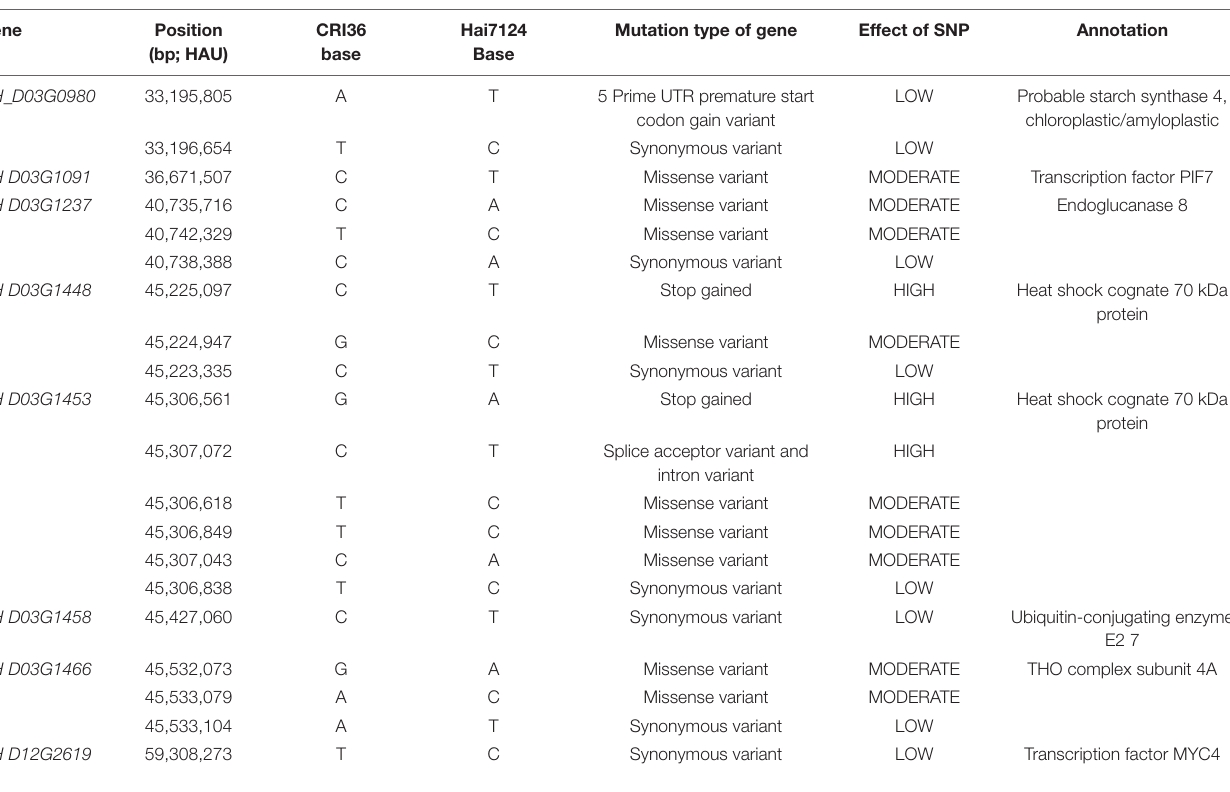
TABLE 4 | SNPs in candidate genes between the two